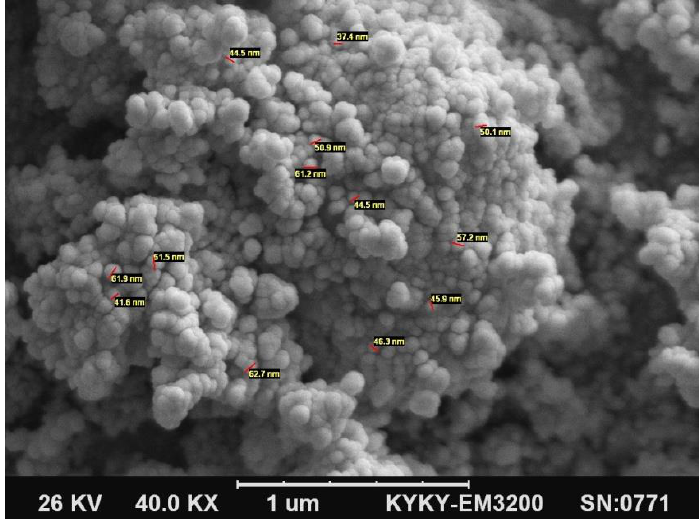
Figure 1. The SEM image of SiO 2 nanoparticles with an overall diameter of 40 nm.